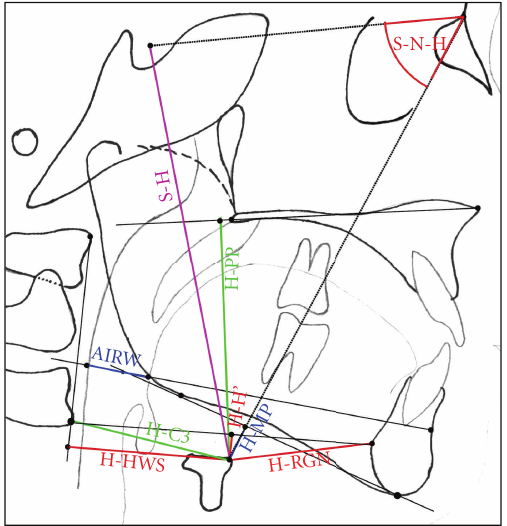
Figure 5: Variables measured to evaluate position of the hyoid. (angel S-N-H: hyoid position, AIRW: airway, that is, distance aAw- pAw).